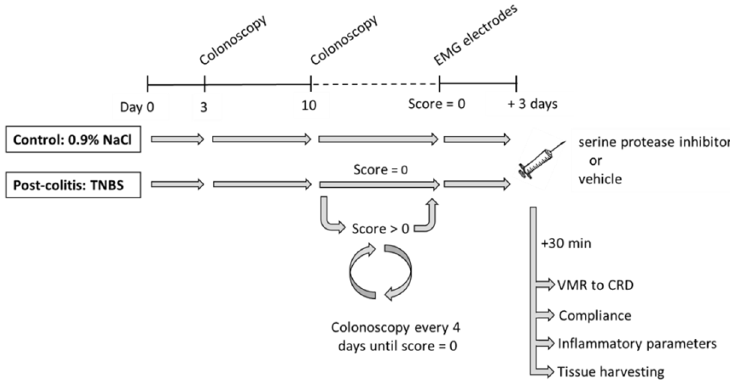
Figure 1. Schematic overview of the experimental design. After induction of distal colitis with an enema containing 2,4,6-trinitrobenzenesulfonic acid (TNBS), the course of colitis was monitored endoscopically on day 3 to confirm the presence of and assess the severity of colitis, and then every 4 days, starting from day 10, until full mucosal healing was observed. Then, electromyographic (EMG) electrodes were implanted. Three days later, animals received an enema containing the serine protease inhibitor UAMC-00050 or its vehicle (5% DMSO). Further experiments were conducted sequentially, 30 min later. CRD, colorectal distensions; EMG, electromyographic; TNBS, 2-4-6- trinitrobenzenesulfonic acid; VMR, visceromotor